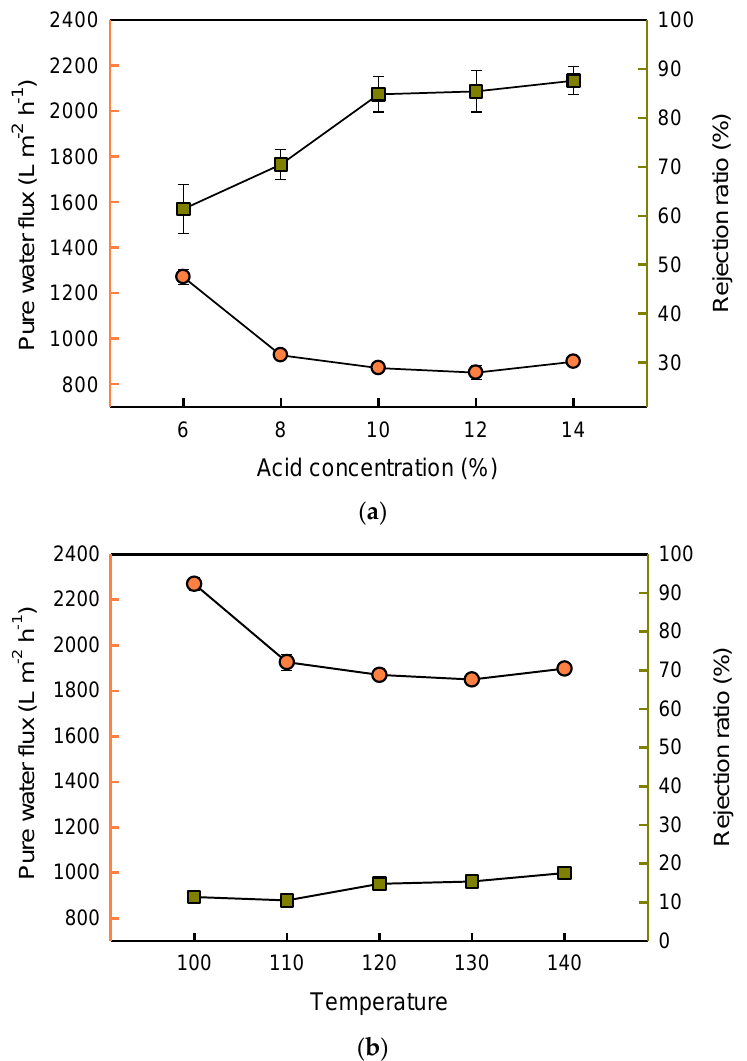
Figure 4. Pure water flux and rejection ratio of the composite membrane by acid-curing and heat-curing, respectively ( a ) Effect of hydrochloric acid concentration on the membrane performance ( b ) Effect of temperature on the membrane performance.